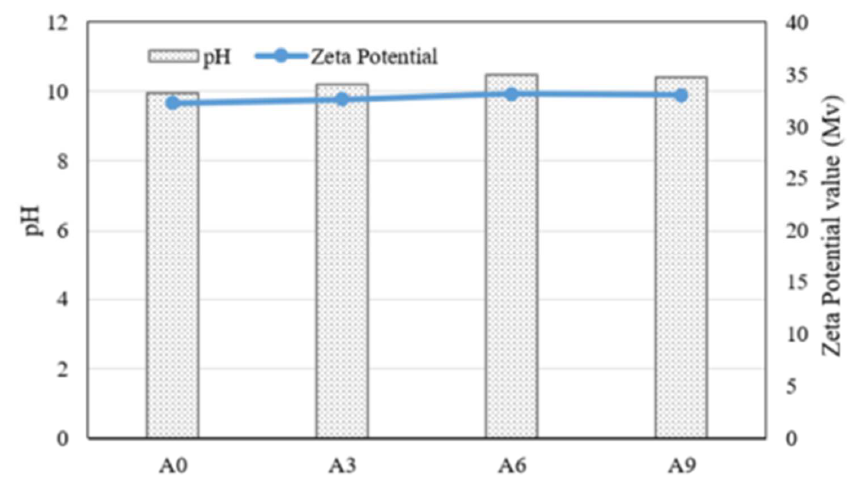
Figure 1. pH and zeta potential of culture media that incorporated different amount of the AE agent at 1 day of incubation.